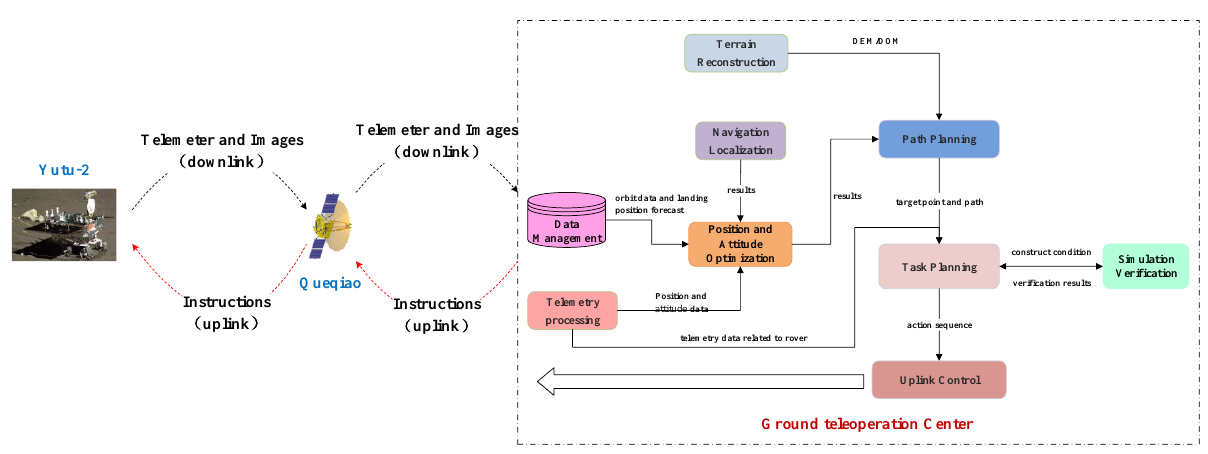
Figure 1. Teleoperation diagram for the Yutu-2